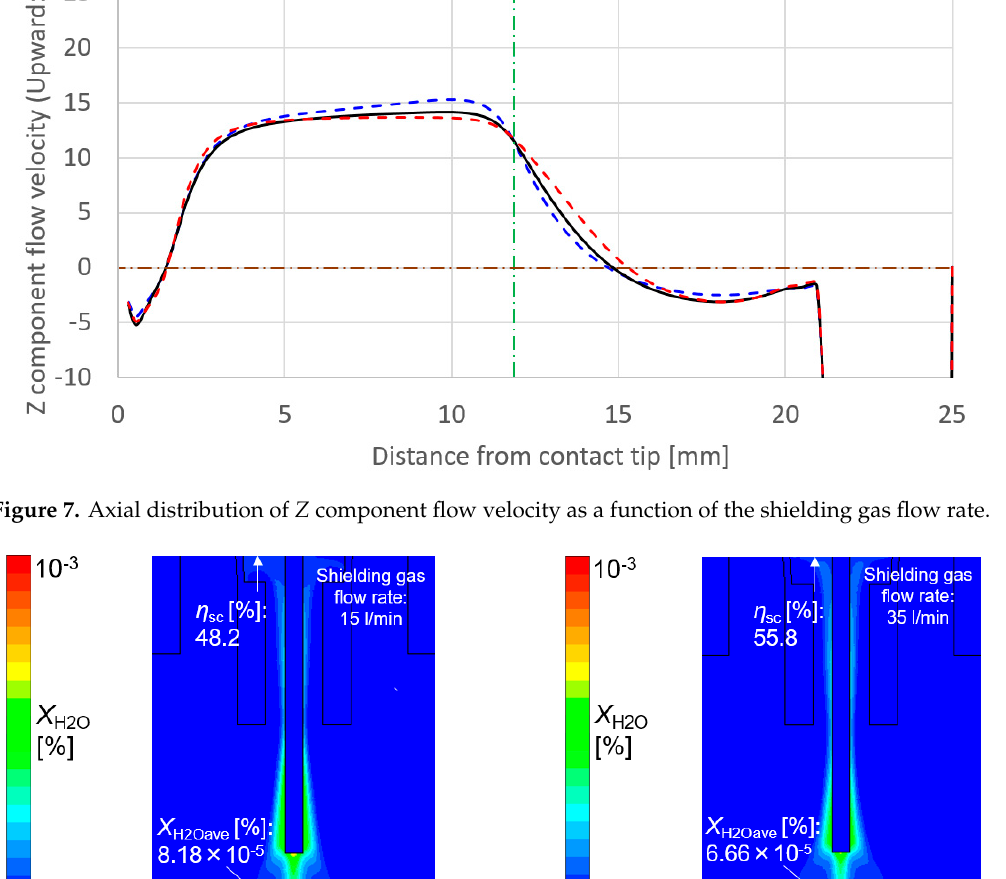
Figure 9. The measured diffusible hydrogen content and the averaged H 2 O mole fraction as a function of the shielding gas flow rate. Figure 10–13 show the effect of the suction rate. In Figure 10 and 12, the results at 3 and 10 l/min are presented. The gas flow velocity in the vicinity around the suction nozzle largely rose as the suction gas rate increased. In addition, the suction limit height lowered when the suction gas rate was 3 l/min. Figure 12 indicated that even if the higher suction gas rate is set, the higher η sc does not obtained. At a suction gas rate of 10 l/min, η sc was 48.8% against 59.6% at a suction gas rate of 3 l/min, and thus this leads to a difference of X H2Oave between two suction rate cases. The H 2 O in the gas was transported by advection and diffusion, as presented in Equation (5). If diffusion plays an important role in the transport process of H 2 O, the increase in the gas flow velocity in the vicinity around the suction nozzle is thought to increase η sc . However, such a tendency was not seen in the result. This implies that the advection dominates the transport process. Figure 13 shows the measured diffusible hydrogen content and X H2Oave as a function of the suction rate. The diffusible hydrogen content was